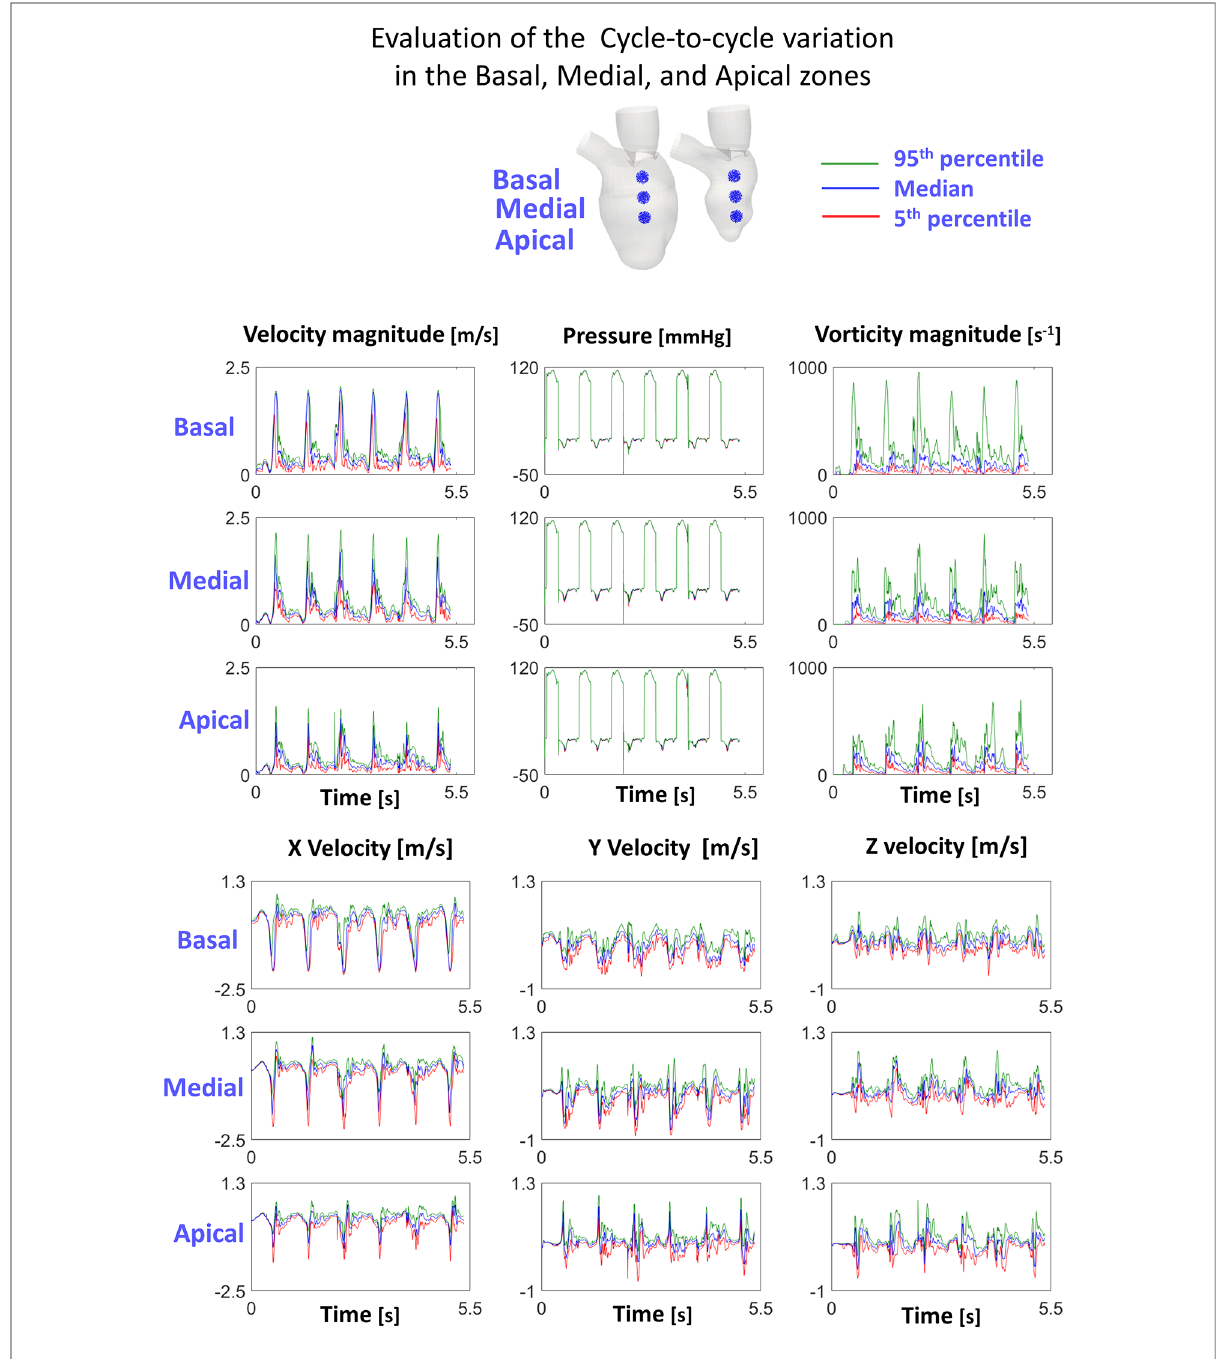
FIGURE 3 Cycle-to-cycle variation in the investigated cloud points shows that the transitional effects are still